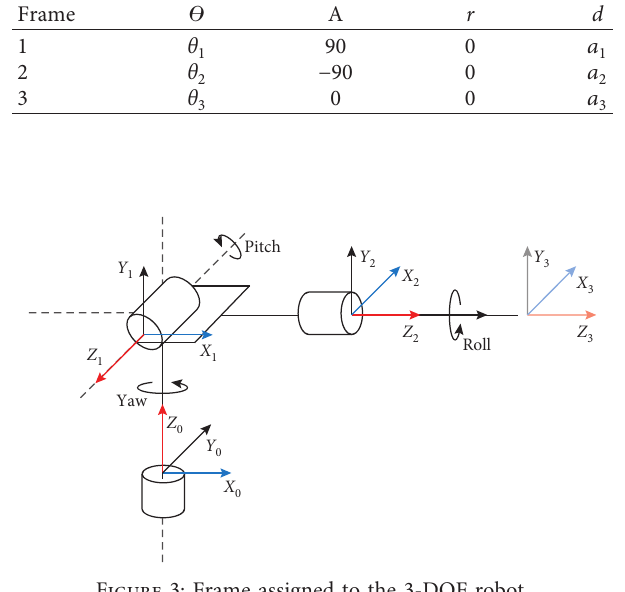
Figure 3: Frame assigned to the 3-DOF robot.